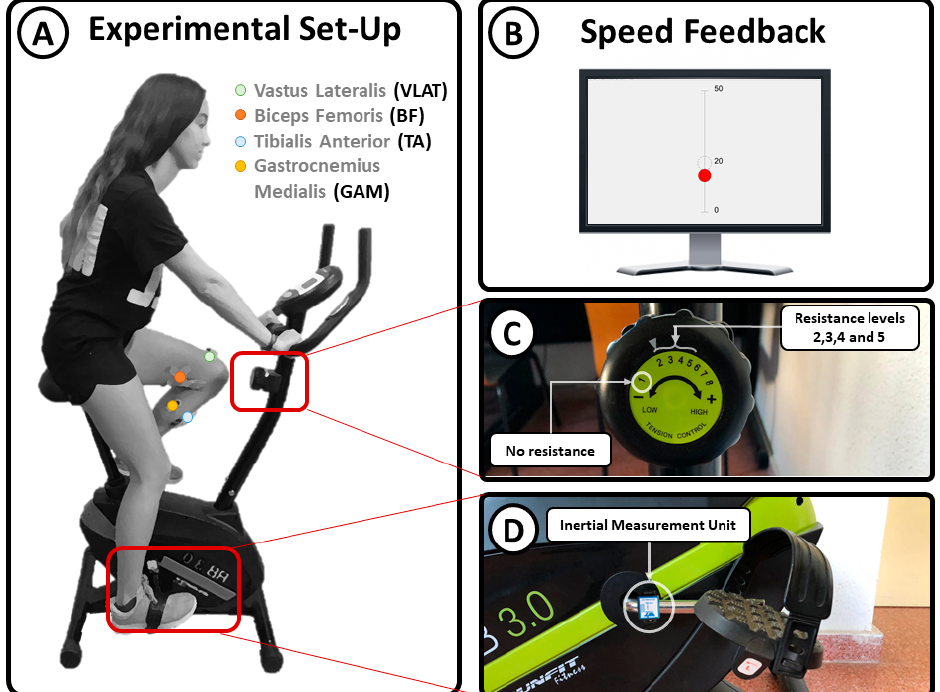
Figure 1. Experimental setup: ( A ) participant position and sEMG electrode location; ( B ) cycling speed feedback; ( C ) resistance level adjustment; ( D ) location of the inertial sensor used to measure cycling speed.